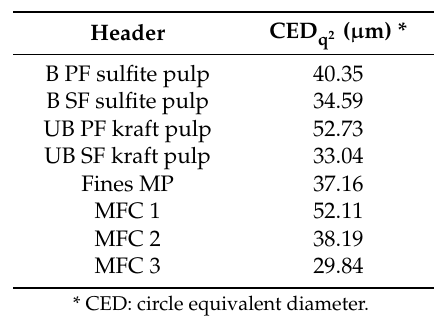
Table 3. Mean particle size of pulp fines (fractionated using the pressure screen) and MFC samples (as provided), measured with the L & W Fiber Tester Plus; resolution 3.3 µ m/pixel.